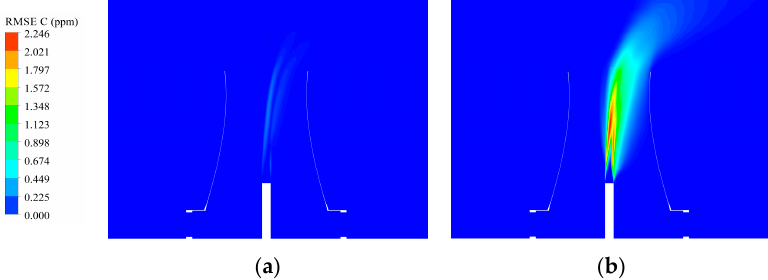
Figure 13. Comparisons of the root-mean-square error (RMSE) pollutant concentration distribution at vertical plane (y = 0 m) of cooling tower: ( a ) URANS and ( b ) LES.